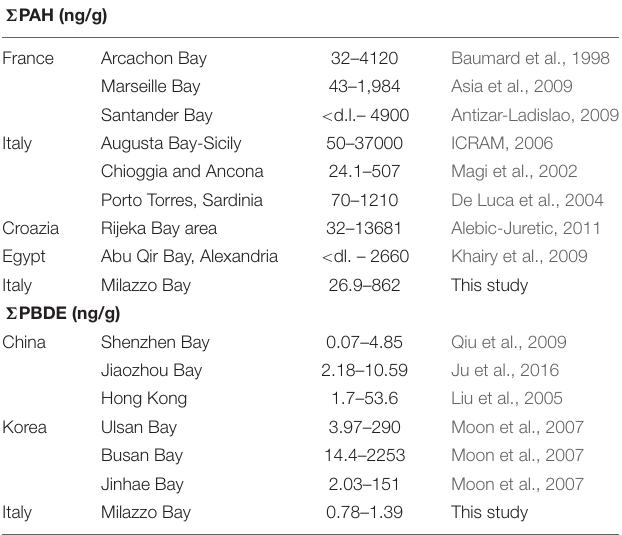
TABLE 3 | Contaminant concentration in sediments from others industrialized bay.